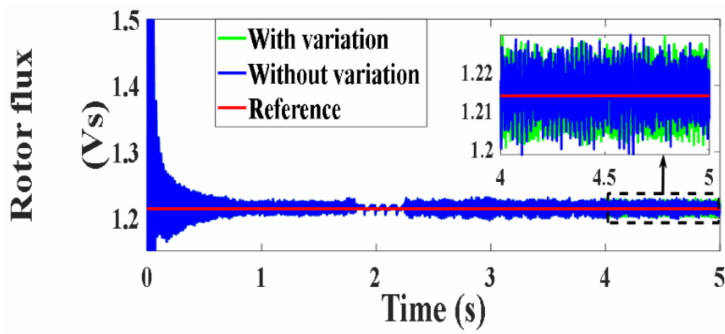
Figure 94. Rotor flux under PVC (Vs).